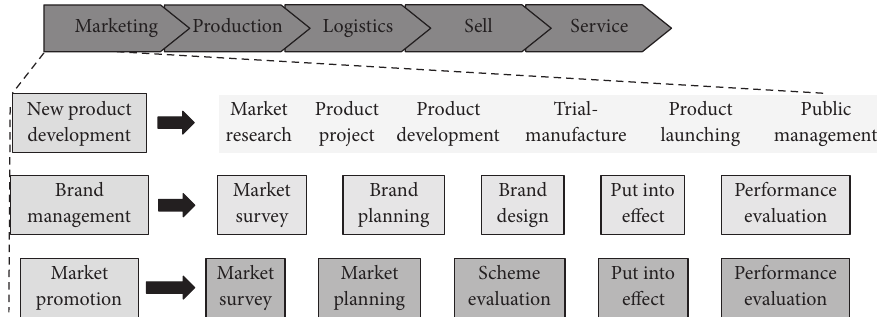
Figure 1: International competitiveness analysis of multinational